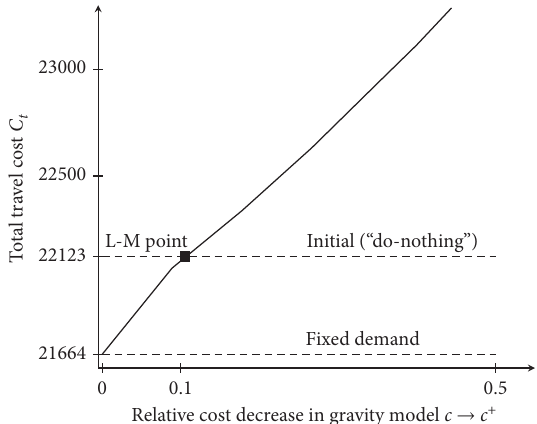
Figure 10: Travel costs C t against relative perceived cost decrease in the gravity